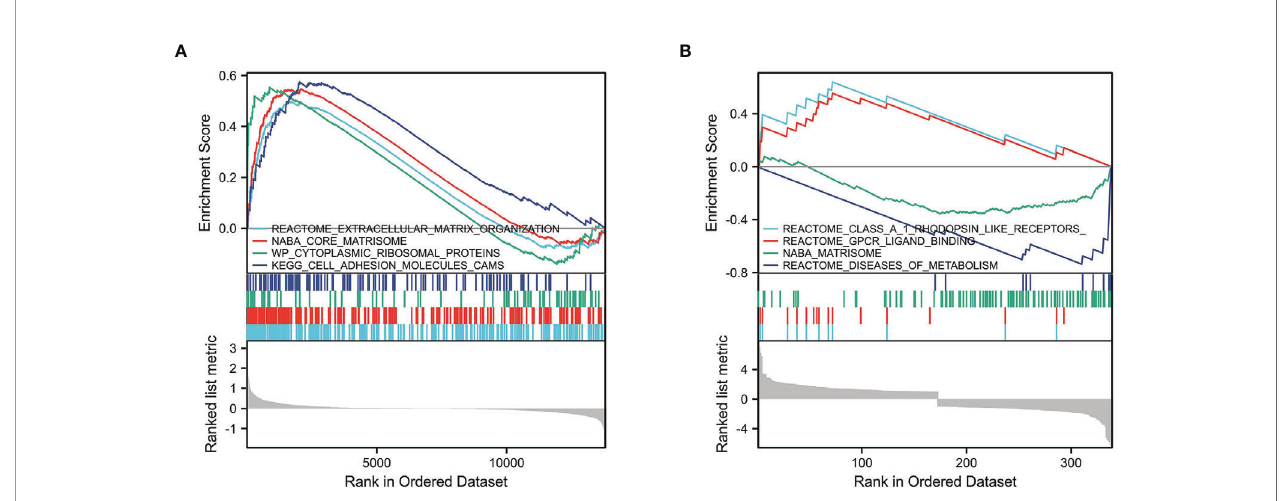
FIGURE 4 | GSEA enrichment analysis. (A) GSEA enrichment analysis in GEO cohort. (B) GSEA enrichment analysis in TARGET